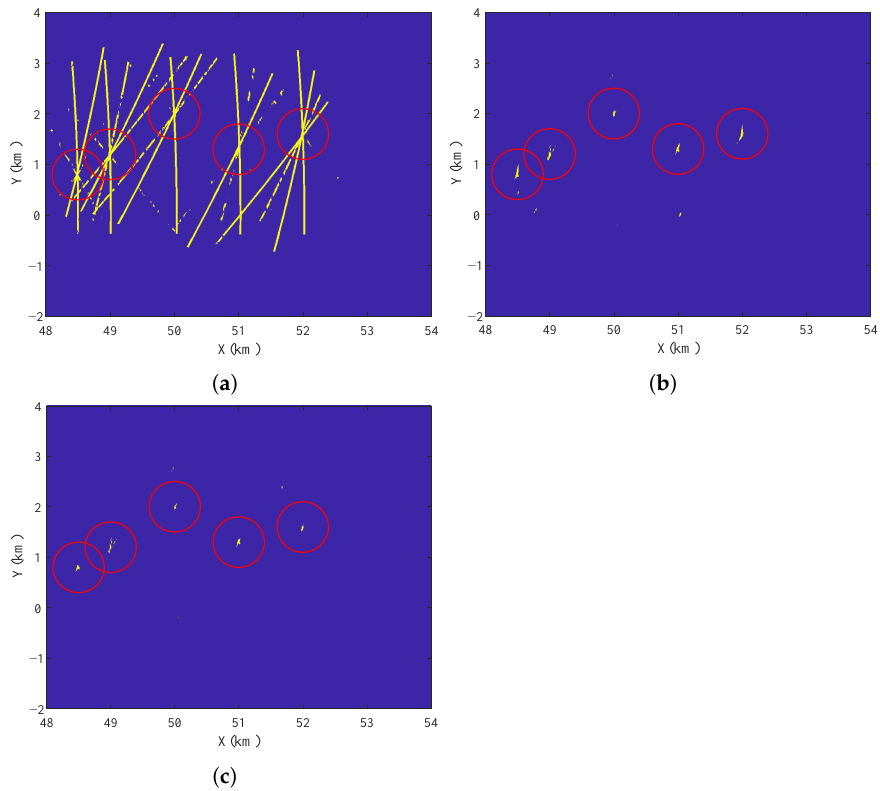
Figure 12. Detection result with five targets when SNR = 2dB. ( a ) The original GLRT detector. ( b ) ID-based detector. ( c ) IC-based detector.